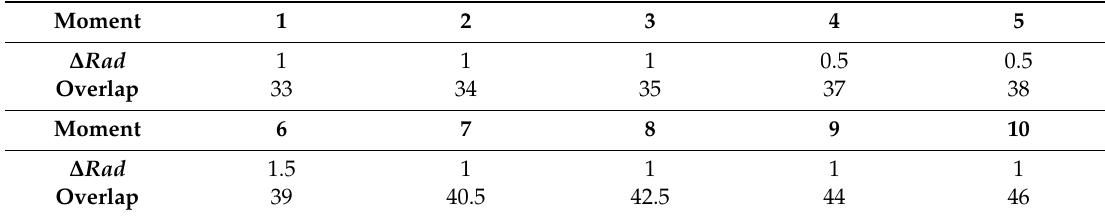
Table 8. The di ff erence of danger sectors before and after considering manoeuvrability in a head-on encountering scenario.